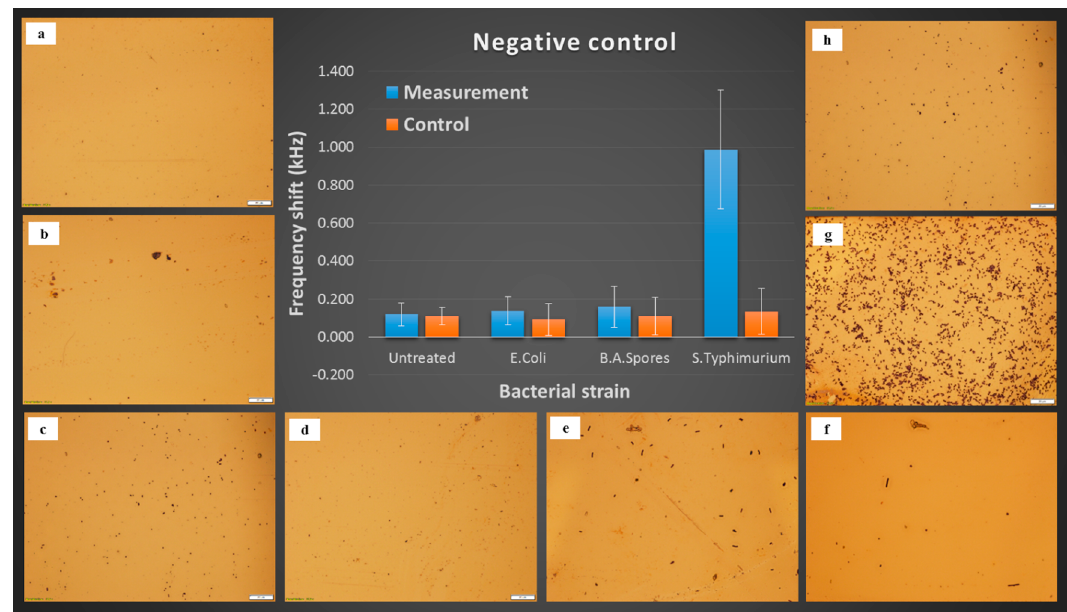
Figure 5. Resonant frequency shifts and sensor surface micrographs (scaleplate 20 μ m) for Negative control, 7 h incubation in LB broth: ( a ) untreated, measurement; ( b ) untreated, control; ( c ) E. coli , measurement; ( d ) E. coli , control; ( e ) B. A. spores , measurement; ( f ) B. A. spores , control; ( g ) S. Typhimurium, measurement; ( h ) S. Typhimurium, control.